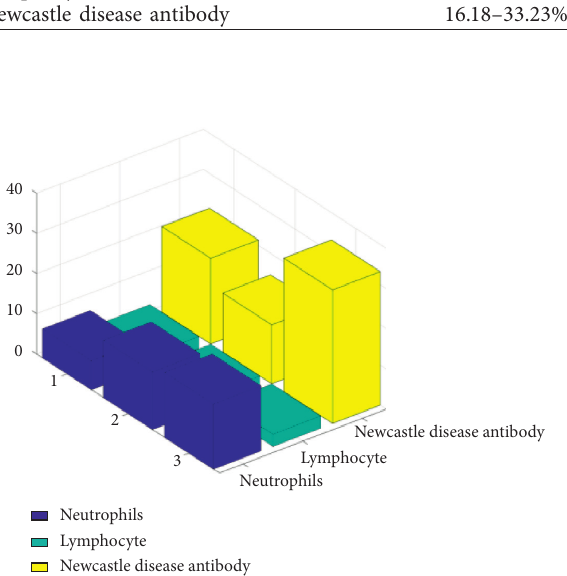
Figure 5: Blood analysis specific